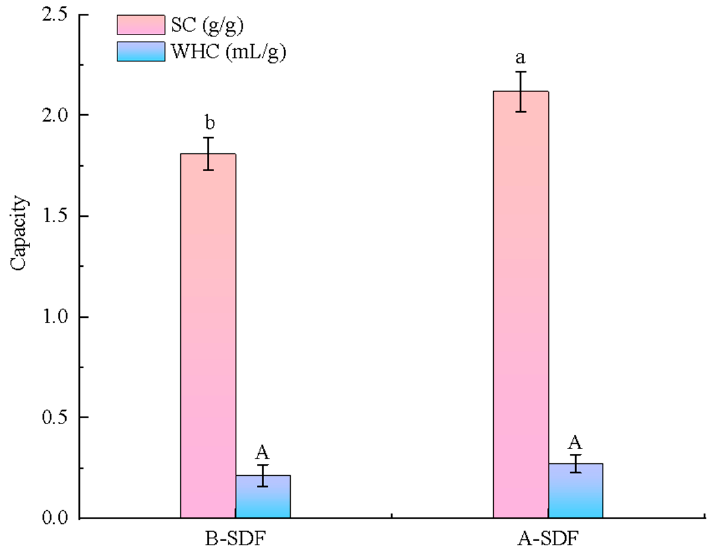
Figure 5. Comparison of swelling capacity and water holding capacity extracted from glutinous rice bran by different methods. B-SDF extracted by the hot water extraction process, and A-SDF extracted by the ultrasound-assisted enzymatic method. Different letters on the top of the column indicate significant differences ( p < 0.05).